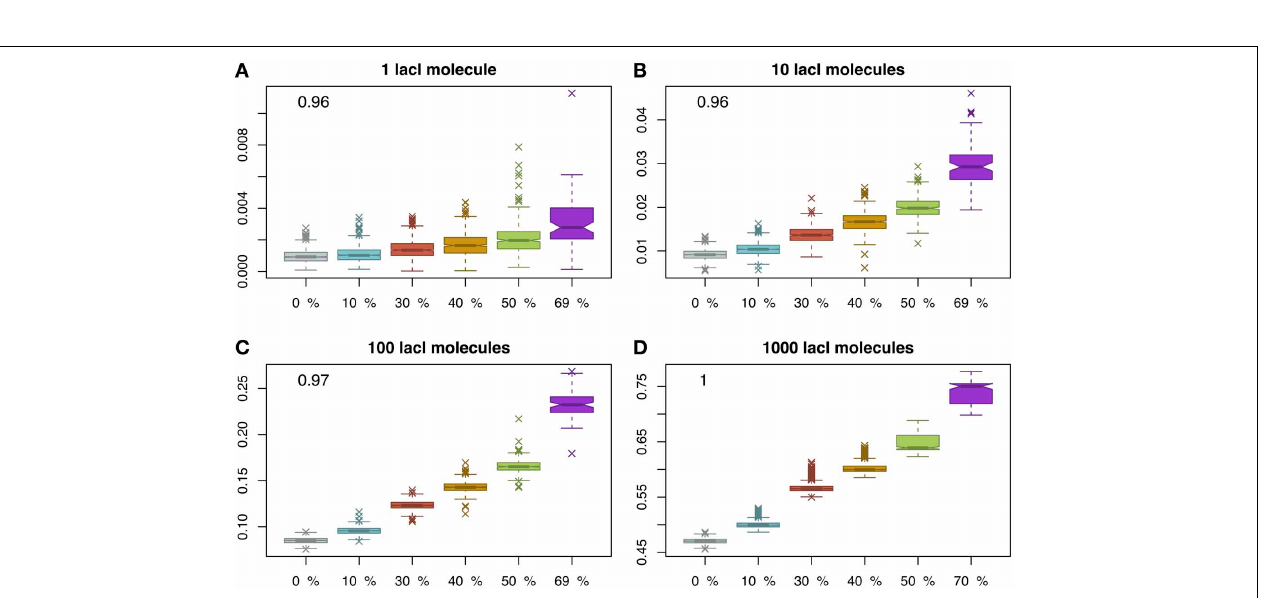
FIGURE 4 | Proportion of time relative to the cell cycle that the target site is occupied (y-axis) as a function of DNA crowding (x-axis) in the case of immobile obstacles. For each set of parameters, we performed 1000 simulations. The mean occupancy of the target site is highly correlated with the crowding level on the DNA for all lacI abundances. Note that, for higher crowding, the number of simulations where the target site is reached within 3000s decreases and, for 70% of the DNA being covered by DNA binding proteins, the probability to locate the target site drops to 0 . 1; see Figure S1 in the Supplementary Material. The number in the inset